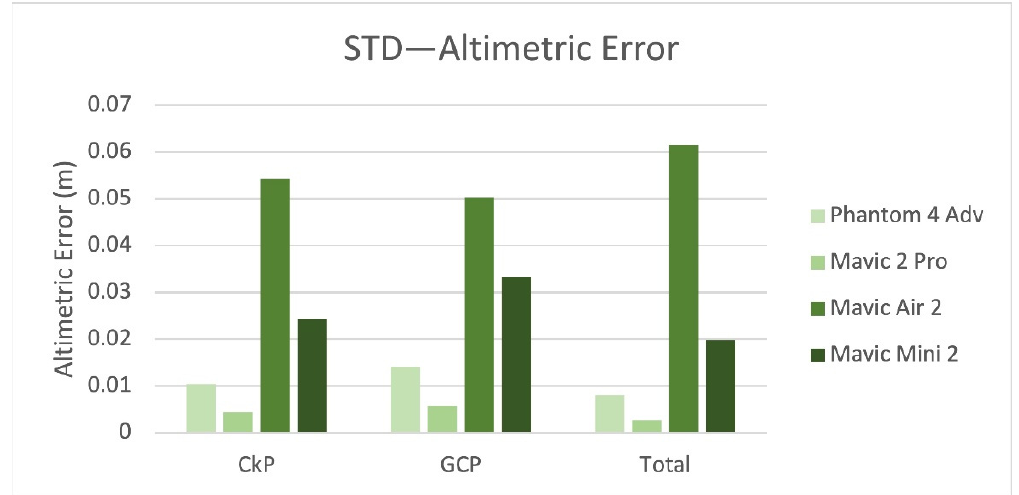
Figure 17. Chart of standard deviations calculated for the altimetric error.